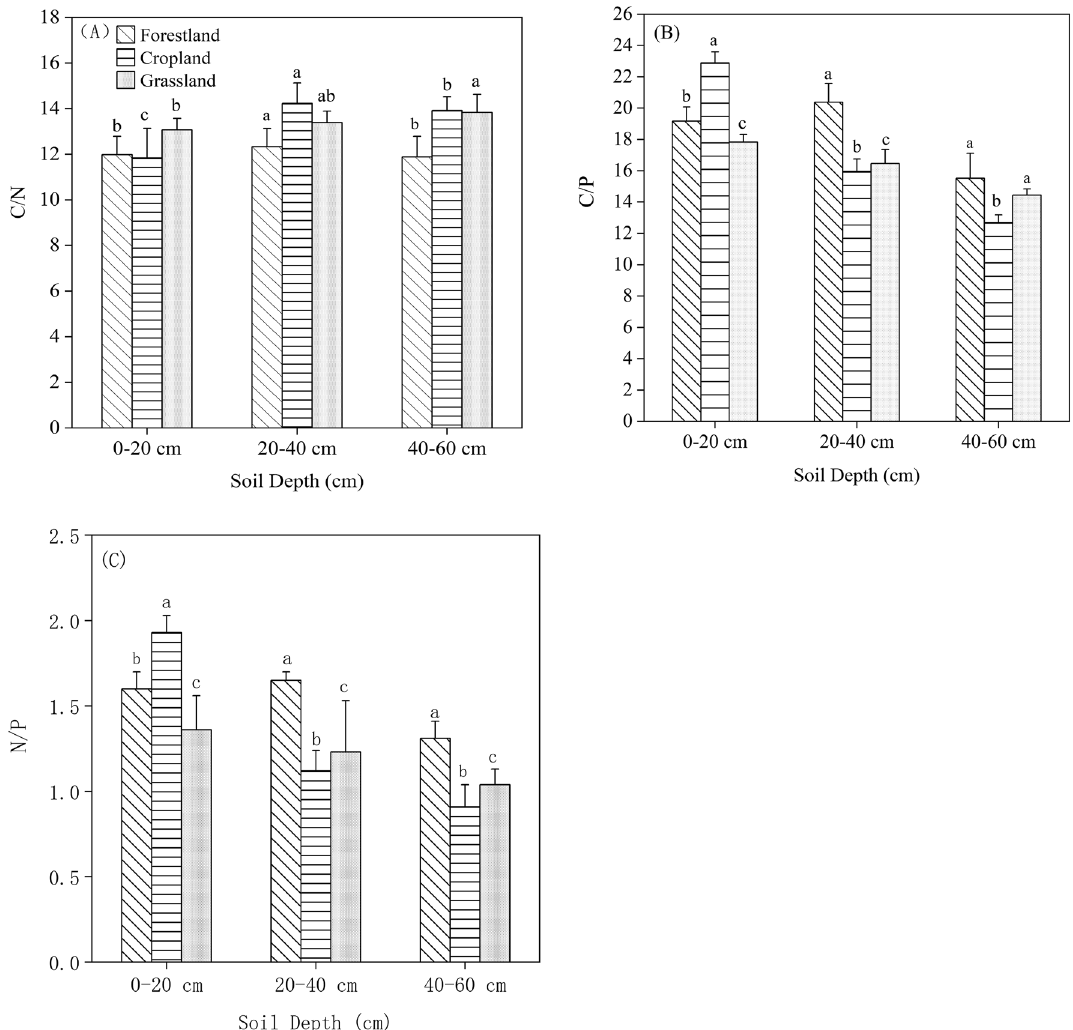
Figure. 3. Variations in soil C/N ( A ), C/P ( B ), and N/P ( C ) stoichiometry ratios in different vegetation types and soil depths, respectively. The same letters indicate an insignifcance between different vegetation types at p <